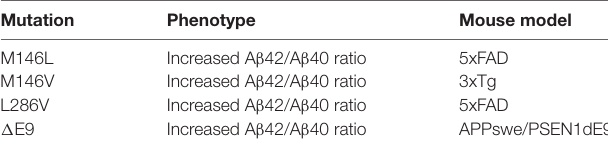
TABLE 2 | Representative FAD-linked mutations in PSEN1 used in model